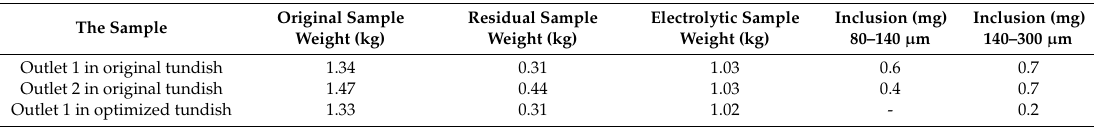
Table 8. Inclusion weight in steel by sample-electrolysing